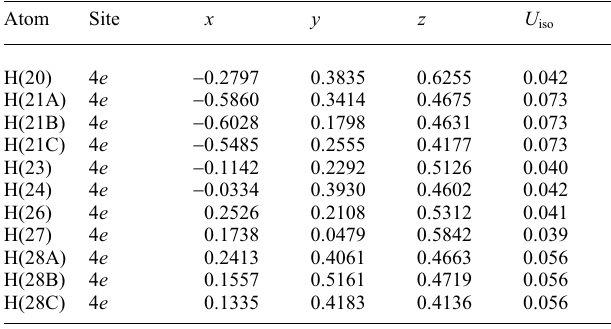
Table 3. Atomic coordinates and displacement parameters (in Å 2